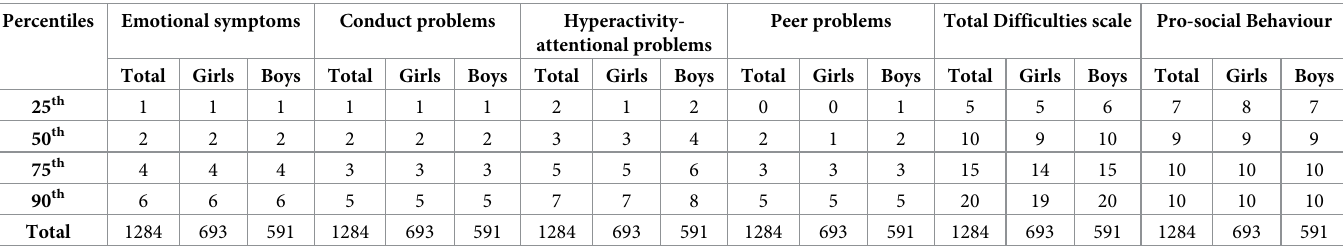
Table 6. Normative data for total scores by sex based on parental report.